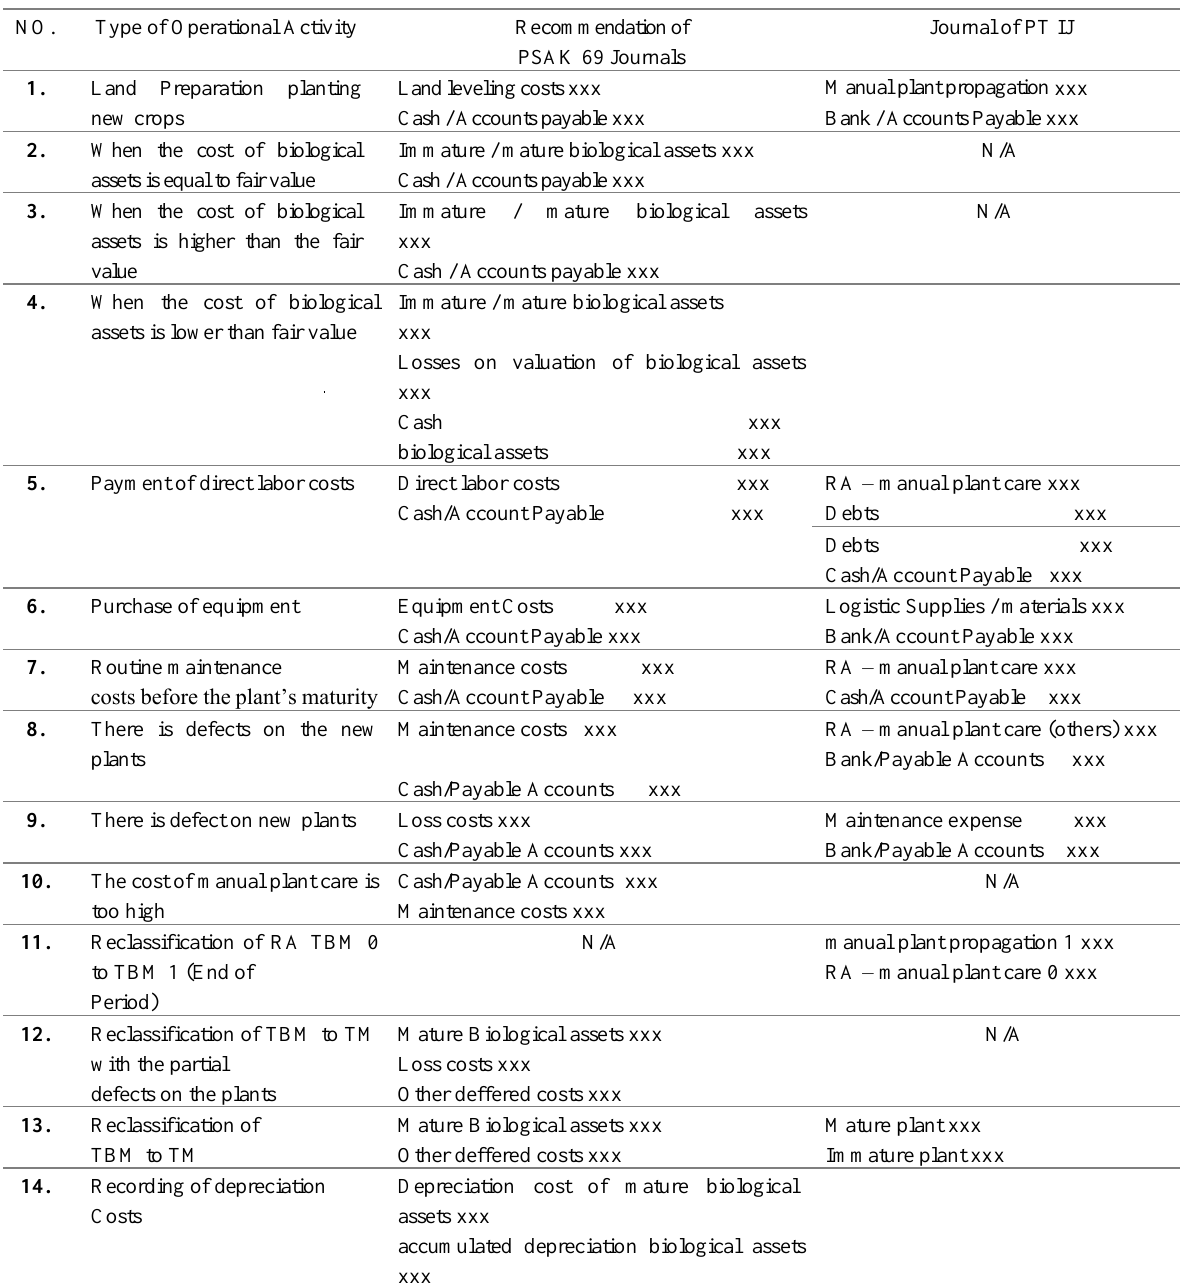
Table 5: Comparison of the recommendation of PSAK 69 Journal to Journal of PT